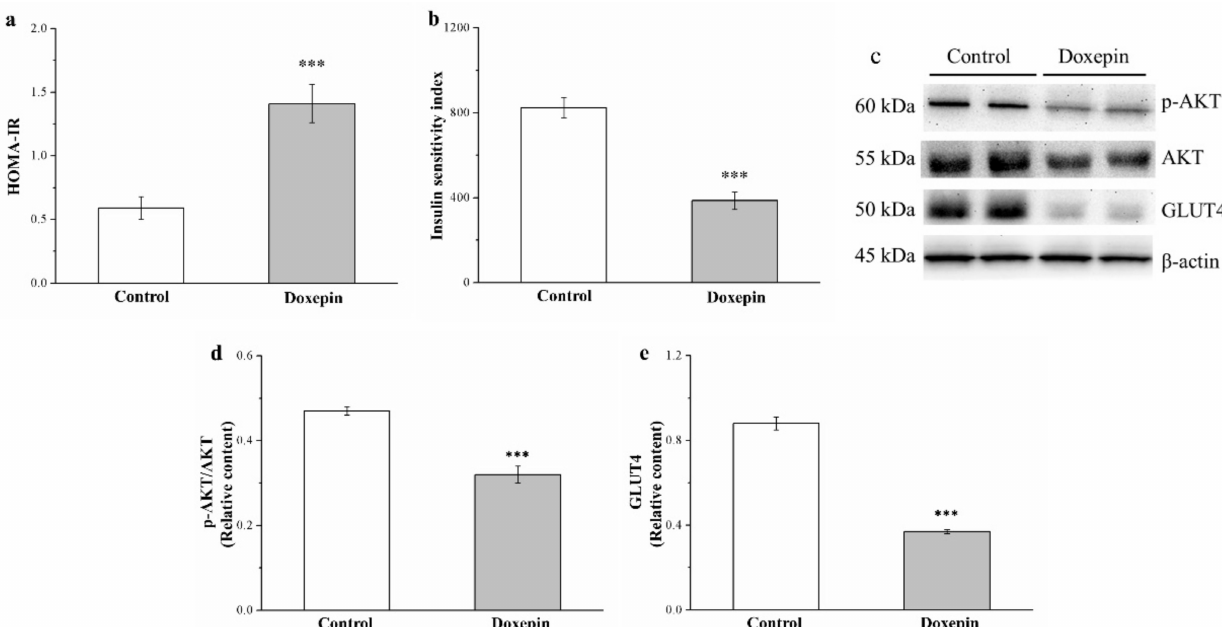
Figure 7. ( a ) HOMA-IR and ( b ) IS indexes, ( c ) representative Western blot of gastrocnemius muscle extracts, ( d ) phospho- Akt, and ( e ) GLUT4 expression levels of the control and doxepin-treated obese mice over 56 treatment days. All values represent the mean ± standard deviation ( n = 10 for all groups). *** p < 0.001 indicates very high statistical significance.